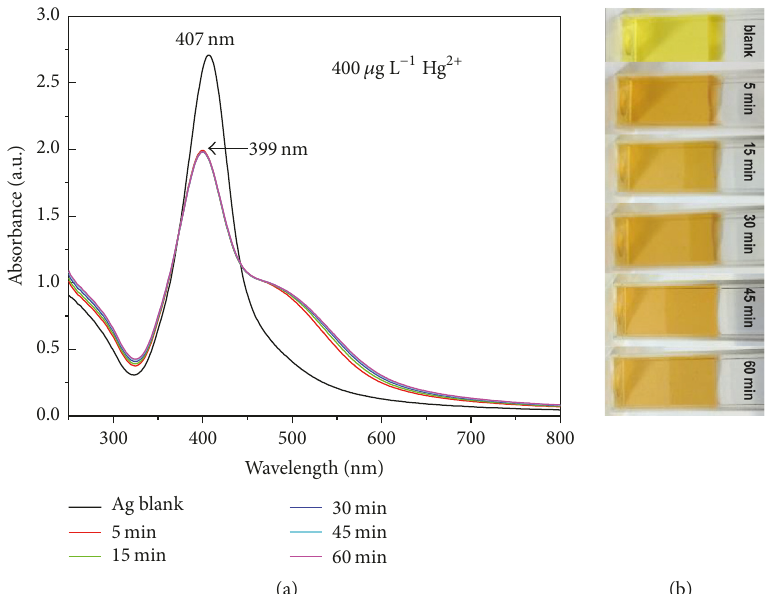
Figure 2: (a) Evolution of UV-Vis absorbance spectrum of AgNPs and (b) color change of the AgNPs dispersion upon the addition of 400 𝜇 gL −1 Hg 2+ in the presence of 0.005 mol L −1 HNO 3 .